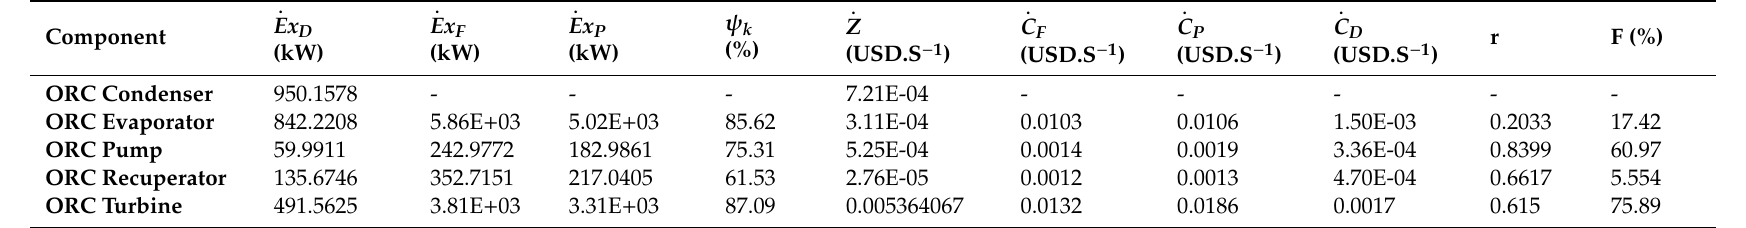
Table 9. Exergo-economic analysis results of the standalone geothermal cycle (GPP).